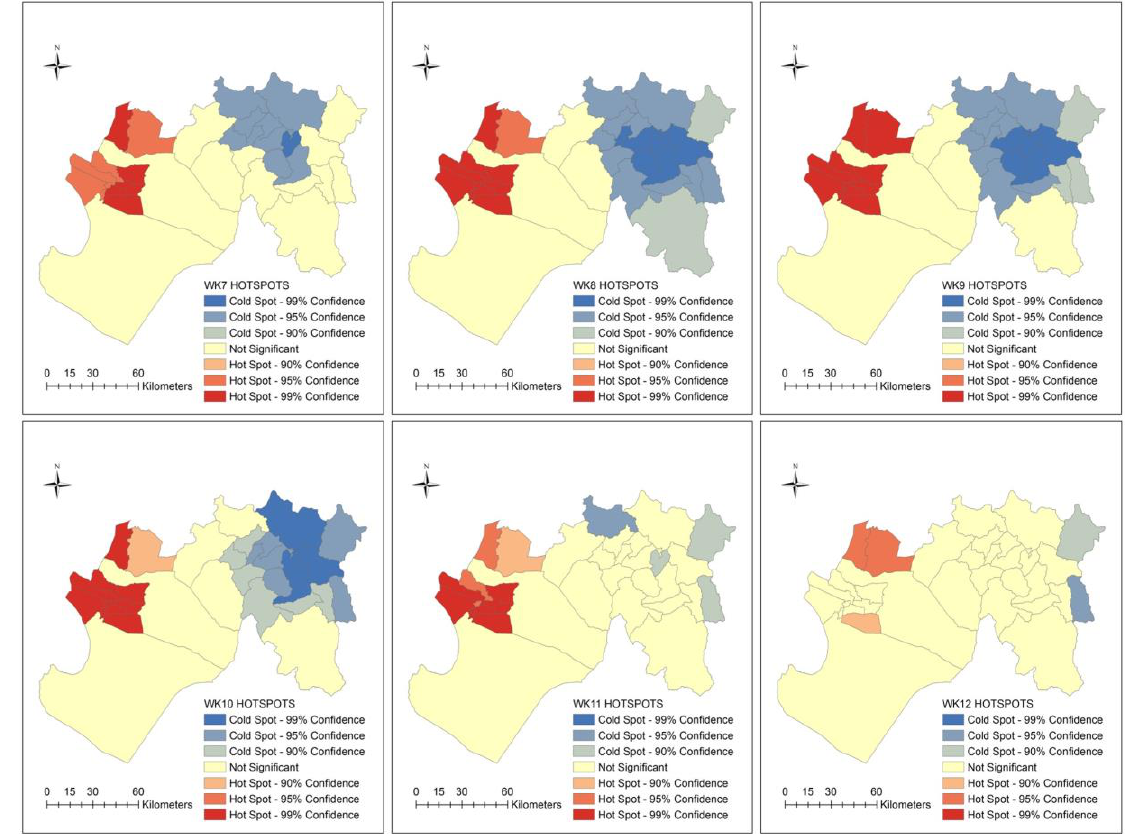
Figure 8. Maps of spatial clusters (hotspots) of the ecosyndemic index at the district-level by week from January to March 1998.